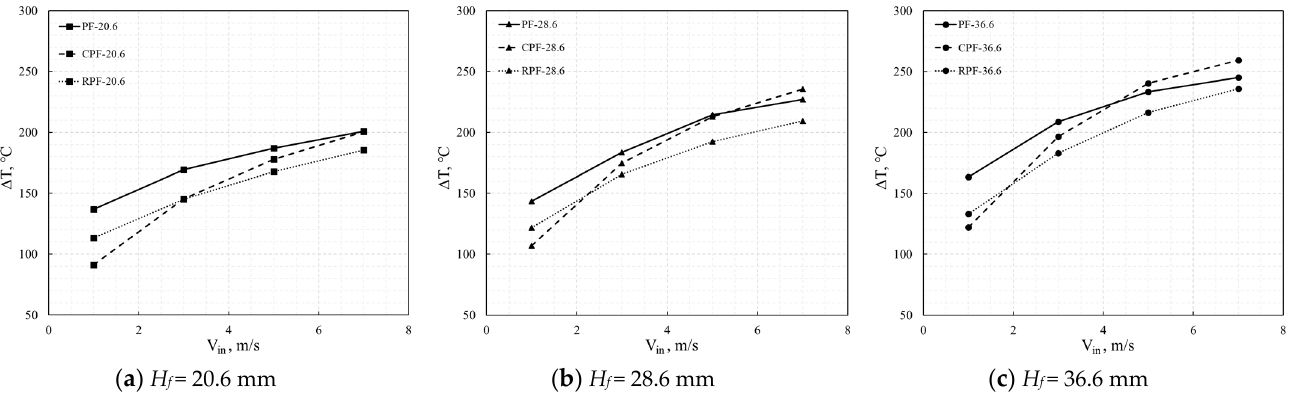
Figure 13. Temperature difference of heat sinks with different fin structures and inlet velocities of flue gas ( T in = 600 °C).